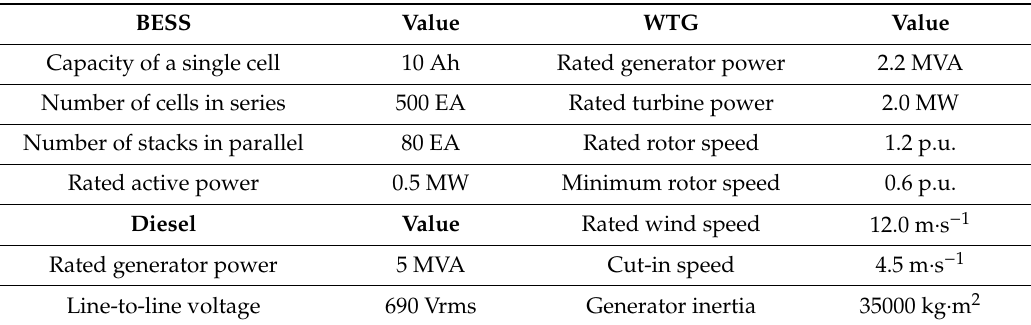
Table 1. Initial values of the microgrid consistence.